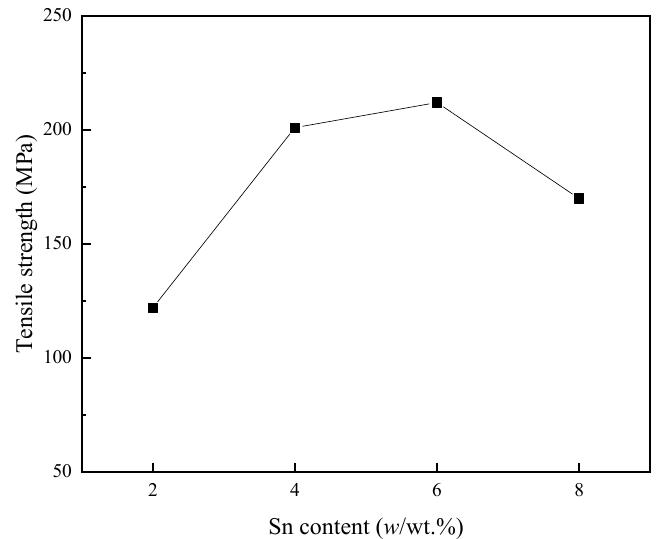
Figure 16. Effects of Sn content on the tensile strengths of Cu/Cu joints brazed by using crystalline Cu-6.5P filler metals [55].